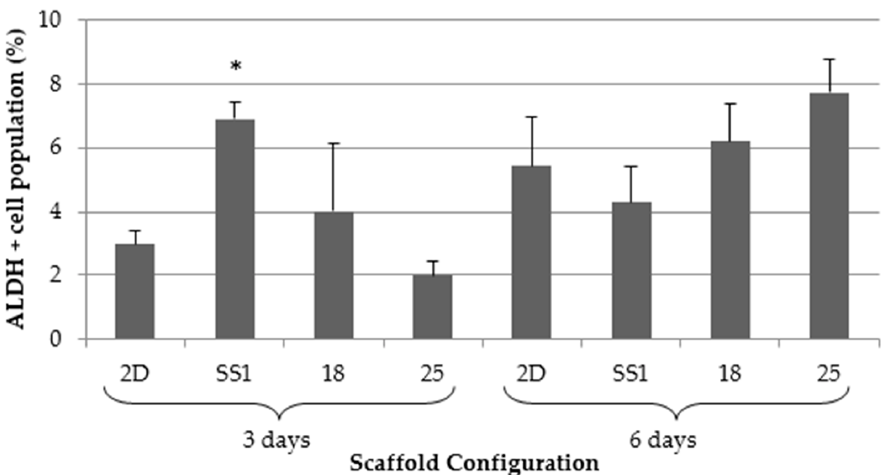
Figure 6. ALDEFLUO TM assay results for three scaffold selected architectures and 2D control for 3 and 6 days. (*) Denotes significant ( p < 0.05) differences between scaffold culture and 2D sample ( n = 3).